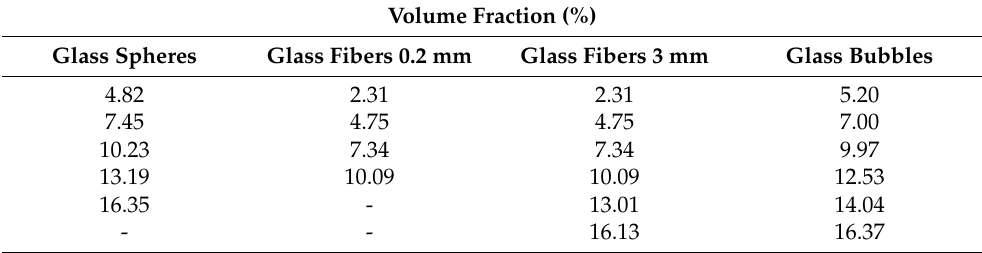
Table 3. Glass filler-volume